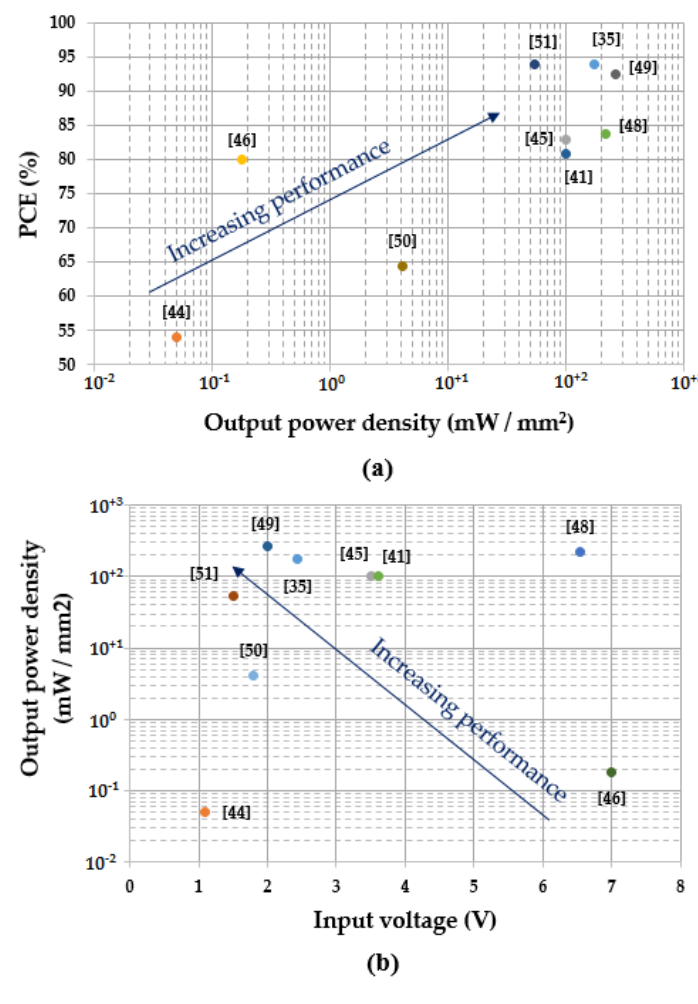
Figure 24. Performance comparison, ( a ) PCE versus minimum output power density and ( b ) output power density versus V in